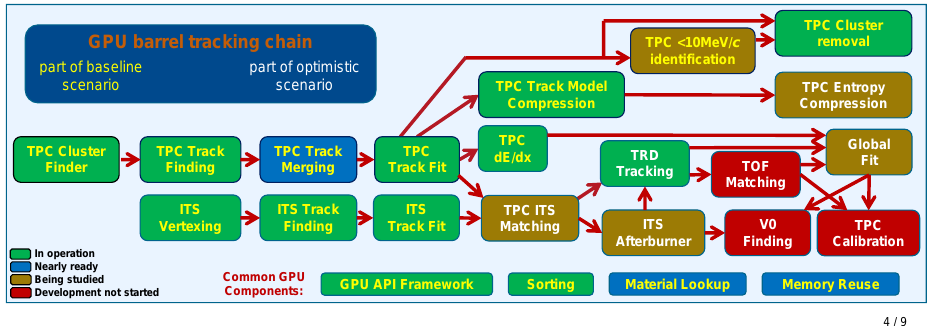
Figure 2. Overview of the relevant processing steps in the central barrel tracking and reconstruction